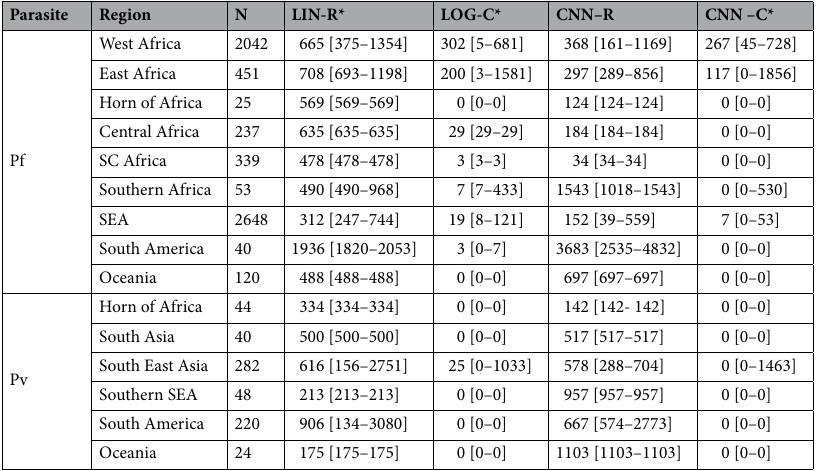
Table 2. Mean distance Error (km) per model by region using geographies included in the training data. Pf P. falciparum , Pv P. vivax, * mean [range], CNN Convolutional Neural Network, SC South Central, SEA South East Asia; LOG-C multinomial logistic regression classifier; CNN-C CNN classifier; LIN-R penalised linear regression model; CNN-R CNN regression